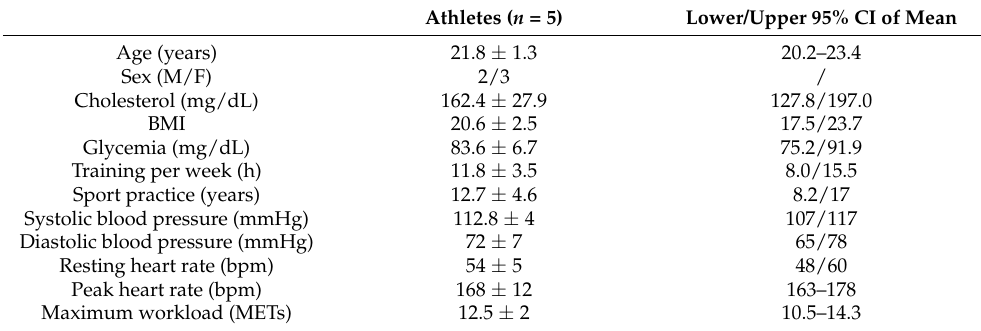
Table 2. Characteristics of